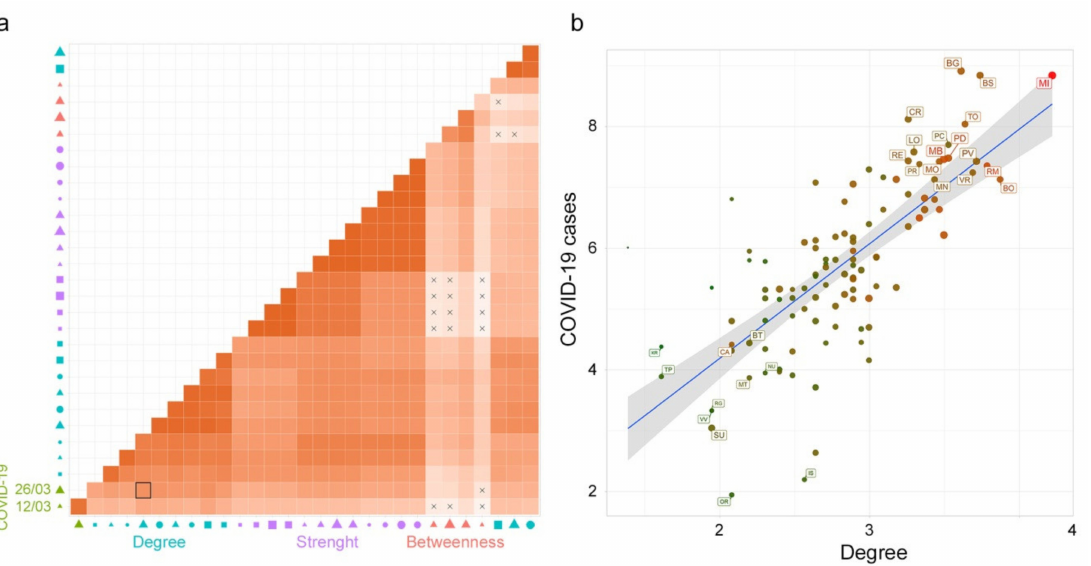
Figure 7. Correlation analysis. ( a ) The heatmap of Pearson’s correlation coe ffi cients among all the variables: Social Network Analysis (SNA) metrics for the rescaled commuting network and subnetworks (with in and out commuters greater than 50, 100 and 1,000), and COVID-19 cases (at di ff erent times). The X symbol indicates a nonsignificant correlation. The red scale color indicates a positive Pearson’s coe ffi cient value. In the x -axis legend, the symbol color represents the variable groups: COVID-19 cases (green), betweenness (red), degree (light blue) and strength (purple); the symbols: circle, square and triangle represent the directions in terms of in (circle), out (square), and none (triangle); the symbol size from smaller to bigger represents the networks variables (subnetworks with in and out commuters greater than 50, 100 and 1,000 and the whole network). ( b ) A scatter plot graph between Deg50 and COVID-19 cases (as of March 26 2020) in the logarithmic scale. The scale color from green to red is used to characterize the in-strength (from a lower to higher number of incoming commuters) of the node and the symbol size (from smaller to bigger) characterizes the node in terms of out-strength (lower to higher number of outgoing